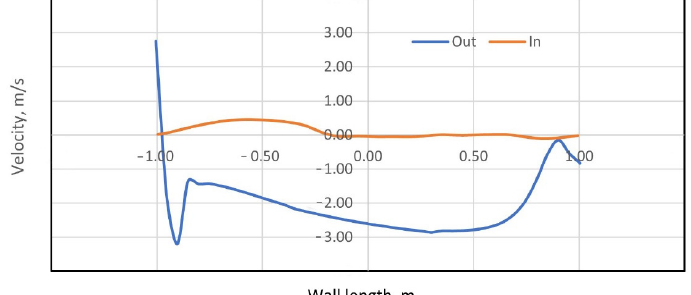
Figure 17. Velocities along the top wall.